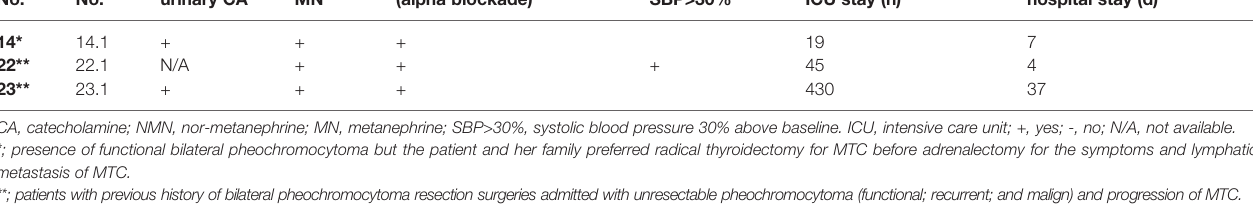
TABLE 5 | Clinical features and outcomes of non-pheochromocytoma resection surgeries (thyroidectomy for medullary thyroid carcinoma, MTC) performed in 3 MEN2A patients with either functional primary or recurrent/malign pheochromocytoma. Patient Surgery No. No.